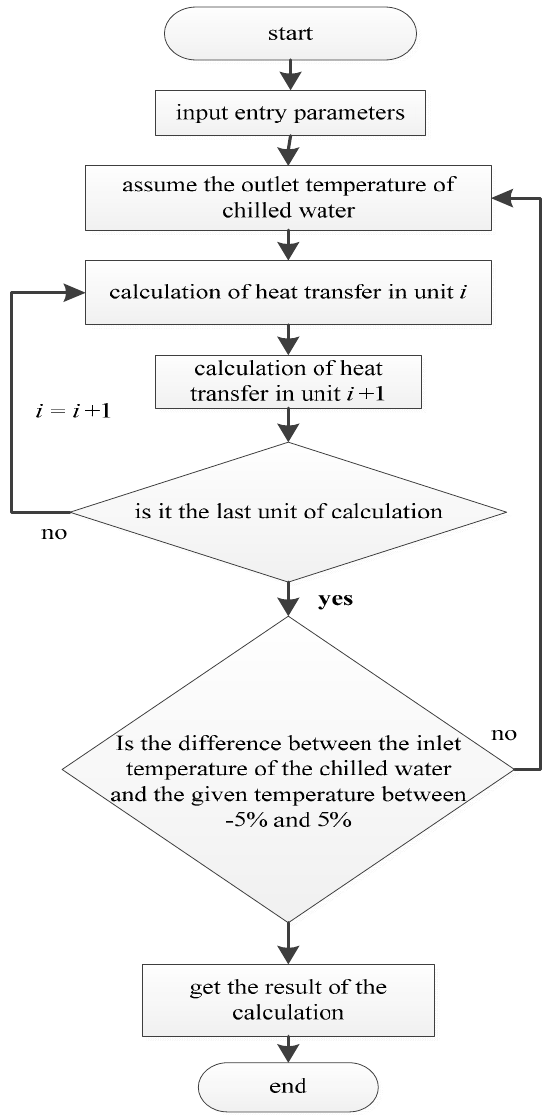
Figure 9. Flowchart of simulation.